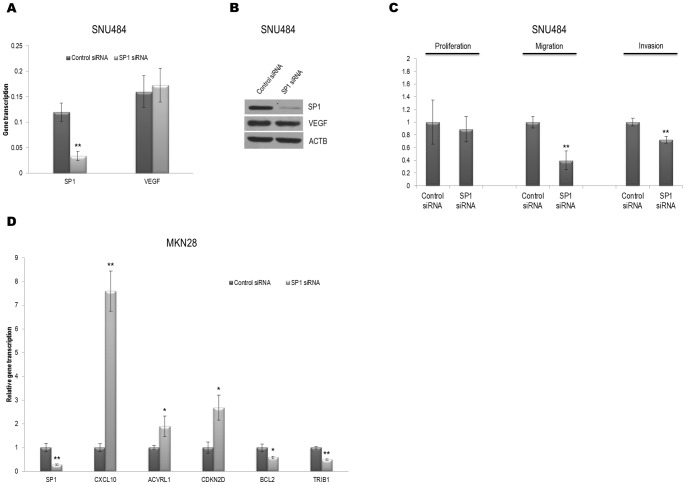
Both cell migration and invasion decrease with decreasing SP1 in SNU484 diffuse-type gastric carcinoma cells, and transcription of genes related to cell proliferation or migration was changed by SP1 siRNA transfection in MKN28.A) SNU484 cells were transfected with SP1 siRNA or control siRNA. Total mRNA was extracted to determine the expression of endogenous VEGF and CDH1 by qRT-PCR. HPRT was used as a control. **, P<0.01. B) Western blot data demonstrate that protein levels of VEGF were not changed by SP1 knockdown in SNU484. ACTB was used as a control. C) Cell proliferation, migration, and invasion were assessed after transfection with SP1 or control siRNA in SNU484. **, P<0.01. D) qRT-PCR of SP1 along with genes involved in negatively regulating either cell proliferation or cell migration after the transfection of SP1 siRNA in MKN28 cells demonstrates that SP1 knockdown promotes the elevation of the cell proliferation-inhibiting genes CXCL10, ACVRL1 and CDKN2D and the reduction of the cell migration inhibition genes BCL2 and TRIB1 at the transcript level. HPRT was used as a control. *, P<0.05; **, P<0.01.